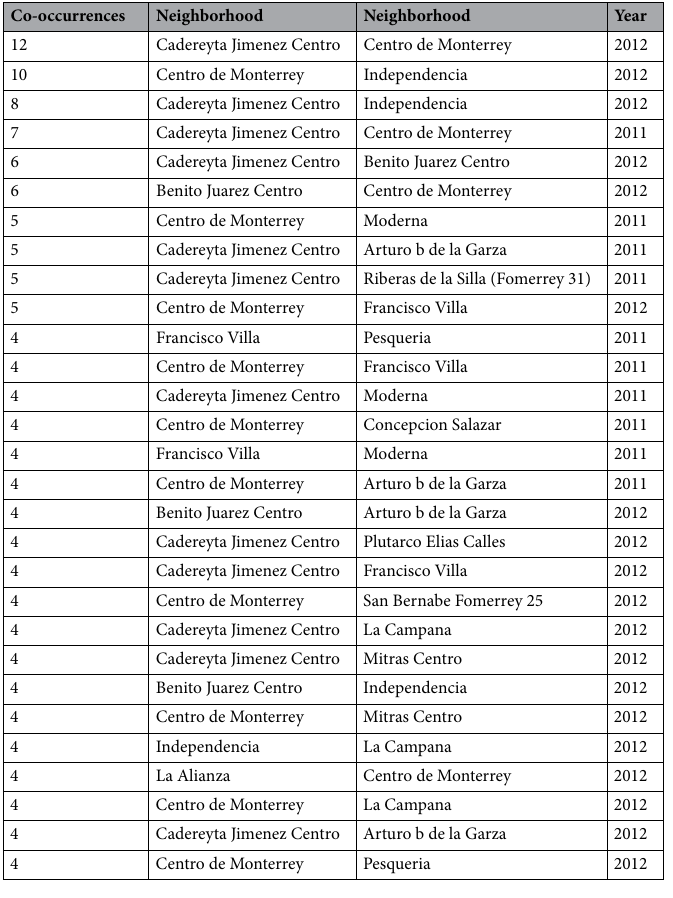
Table 2. Neighborhood pairs with more than three casualty co-occurrences in the same week for a given